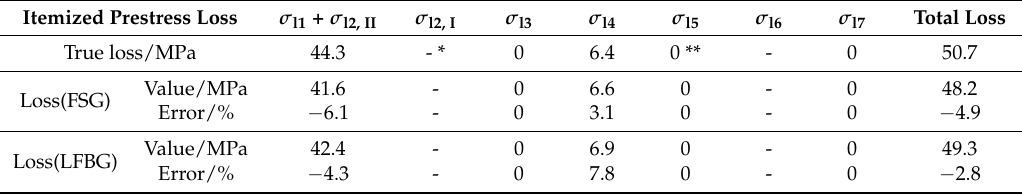
Table 6. Comparison of different prestress losses in the pre-tensioning